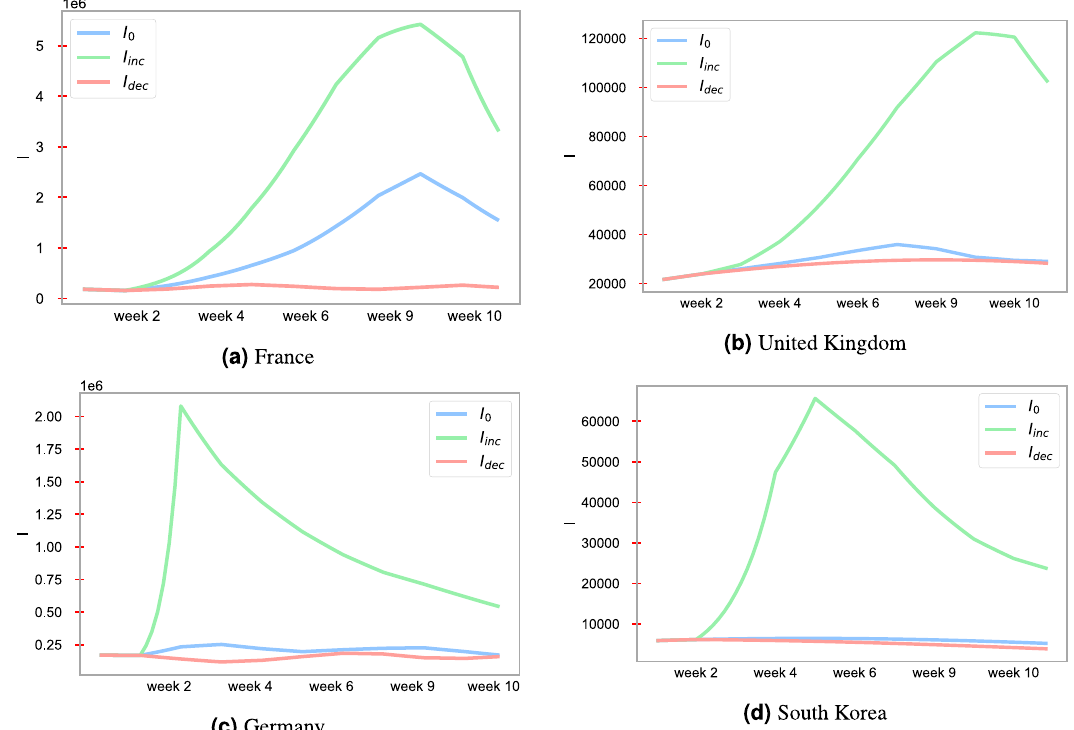
Figure 7. Forecasting the number of Covid-19 infections for France, the United Kingdom, Germany, and South Korea under 30% increased and decreased mobility to normal mobility (baseline mobility). Mobility data is real-time cell phone/mobile device location for each country collected from 32 . Here, I 0 , I inc , and I dec stand for infections with normal, 30% increased, 30% decreased mobility, respectively. The vaccination model is used for the